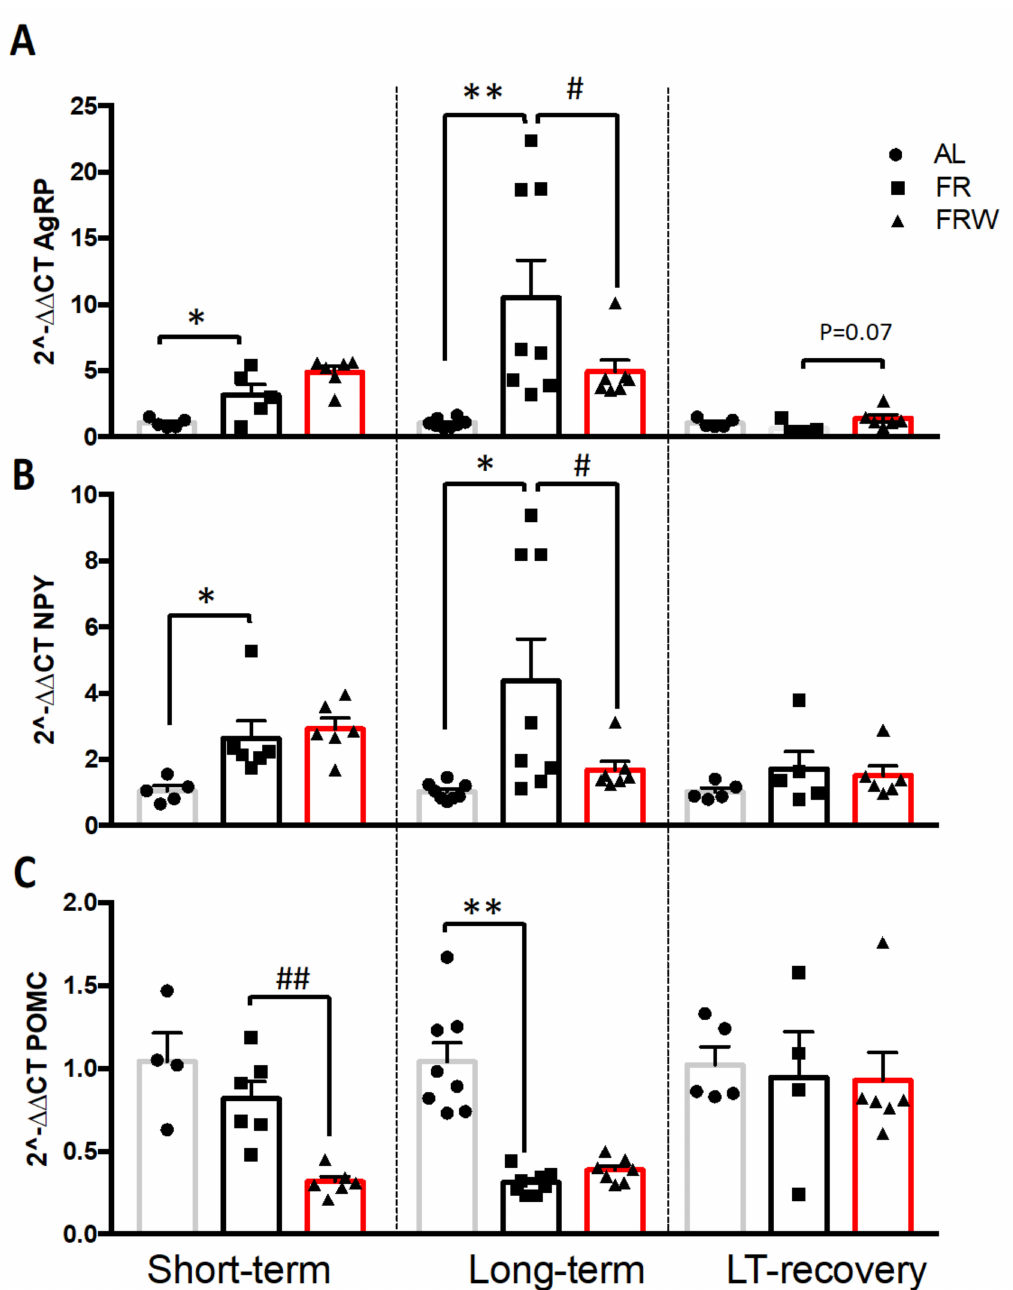
Figure 5. Impact of short-term, long-term (LT) and nutritional recovery (LT-Rec) on the mRNA expression of hypothalamic of agouti-related peptides ( A , AgRP), neuropeptide Y ( B , NPY) and pro-opiomelanocortin ( C , POMC). AL: ad libitum ; FR: food restricted; FRW: food restricted with wheel. Data represent mean ± SEM ( n = 4–8 per group). * p < 0.05 AL vs. FR; # p < 0.05 FR vs. FRW; ** p < 0.01 AL vs. FR; ## p < 0.01 FR vs. FRW.3.2.5. mRNA expression receptors of leptin, ghrelin and AgRP/NPY and melanocortin systems in the